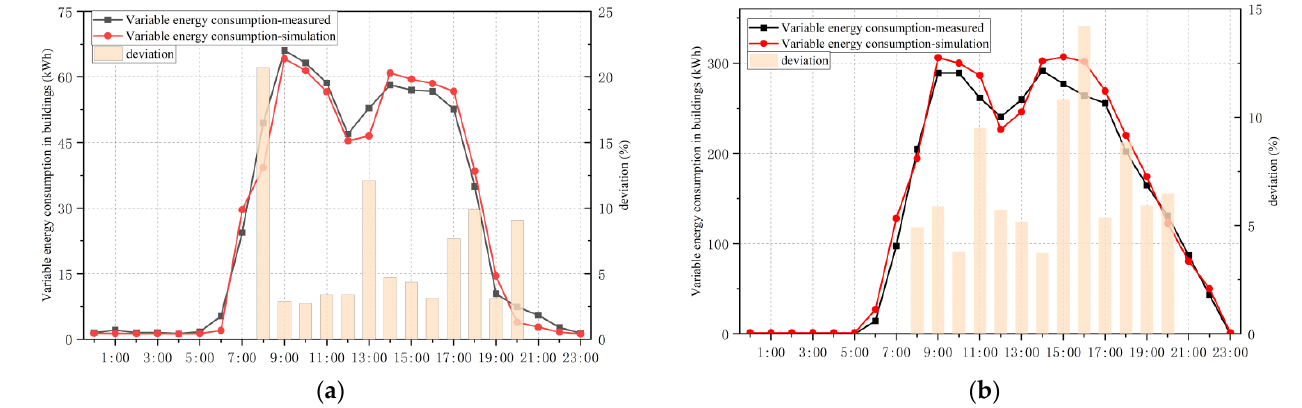
Figure 23. ( a ) Comparison of simulated and measured values of variable energy consumption in